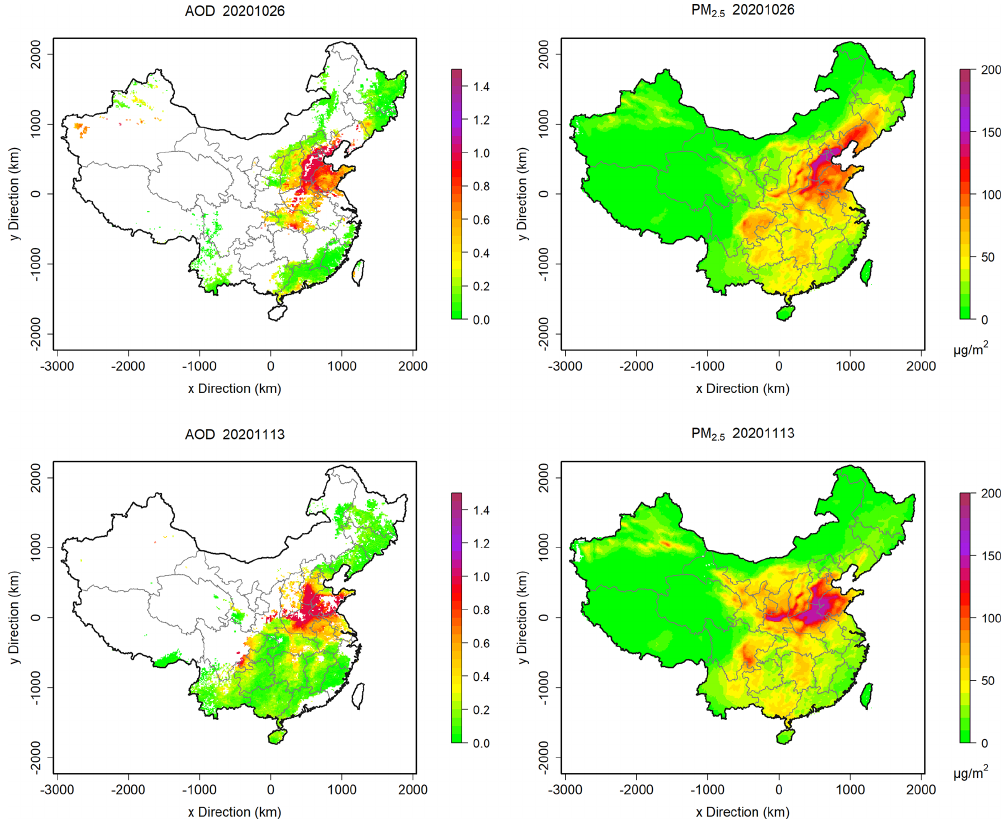
Figure 8. Comparison between MODIS AOD and PM 2 . 5 fusion data on 26 October and 13 November